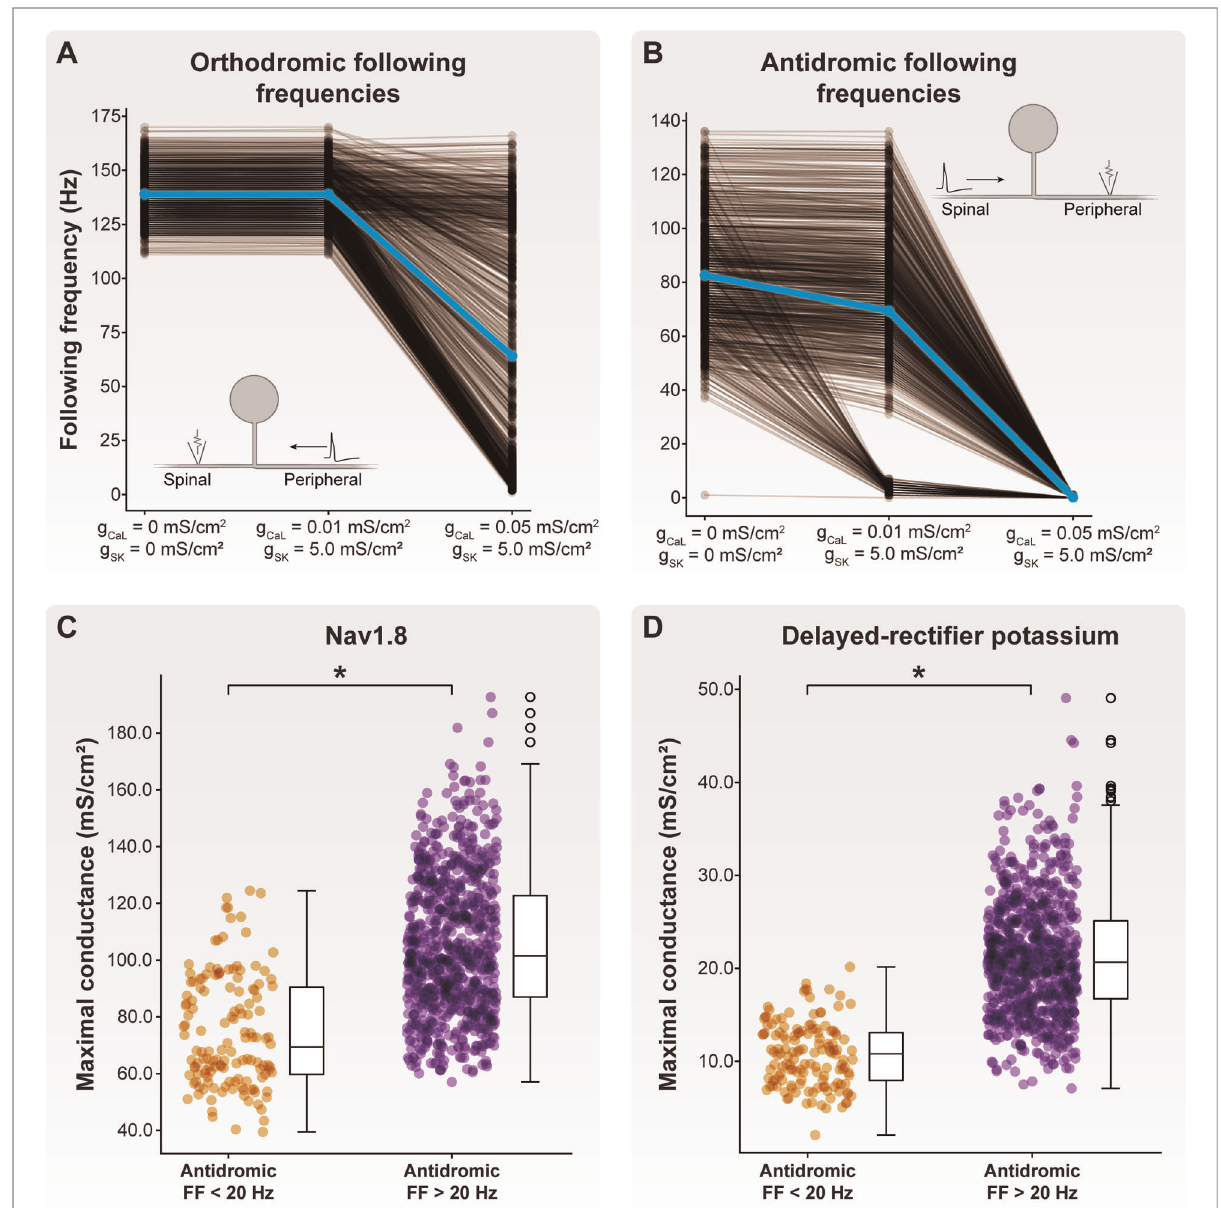
FIGURE 5 Effect of axonal SK and Ca L conductances on following frequency. We fi xed the maximal SK conductance at 5 mS/cm 2 and increased Ca L conductance from 0.01 to 0.05 mS/cm 2 . ( A ) Increasing maximal Ca L conductance to 0.05 mS/cm 2 produced a population of model C-neurons which displayed a wide range of orthodromic following frequencies. ( B ) Setting maximal Ca L conductance to 0.01 mS/cm 2 produced a population of model C-neurons which displayed a wide range of antidromic following frequencies. At this level of maximal Ca L conductance, there appear to be two clusters of model C-neurons: those with antidromic following frequencies greater than 20 Hz, and those with antidromic following frequencies less than 20 Hz. Increasing maximal Ca L conductance to 0.05 mS/cm 2 dramatically reduced antidromic following frequencies. Model C-neurons with antidromic following frequencies greater than 20 Hz had signi fi cantly higher maximal ( C ) Nav1.8 and ( D ) delayed-recti fi er potassium conductances than model C-neurons with antidromic following frequencies less than 20